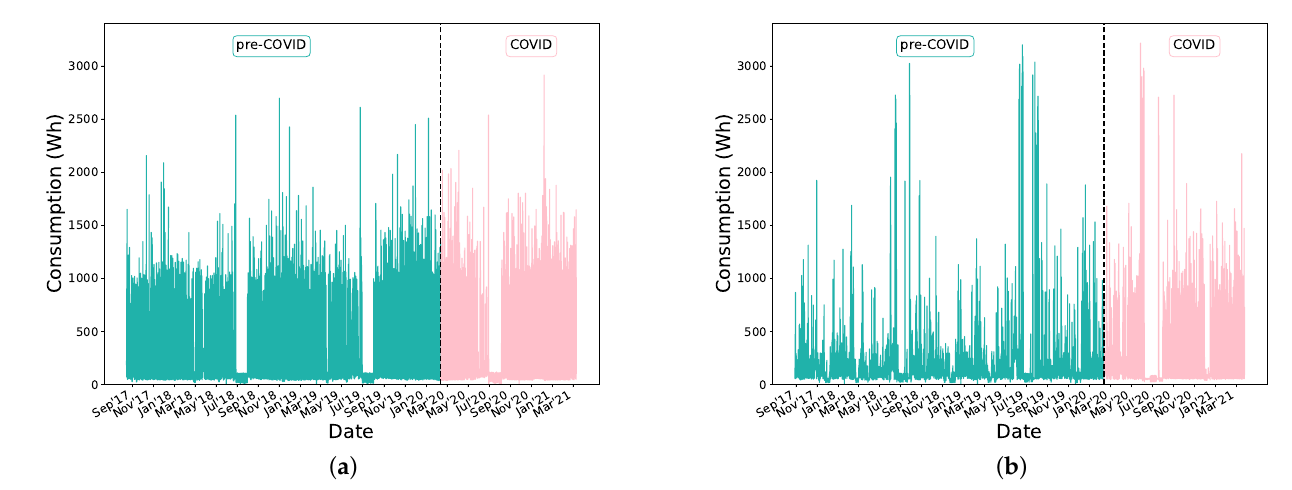
Figure 2 show the total consumption of H1 and H2 during the whole period. The vertical black line on March 14th marks the day when the state of alarm (strict lockdown) was declared in Spain. This line divides the consumption into pre-pandemic and pan- demic periods.